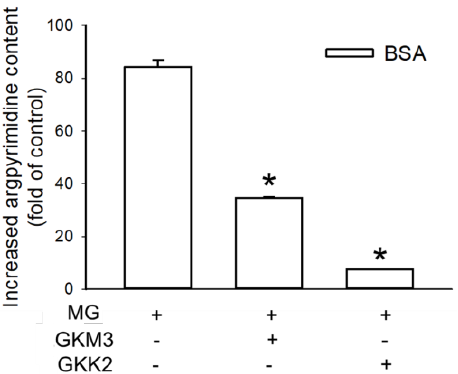
Figure 6. Effect of GKM3 and GKK2 on the formation of advanced glycation end products (AGEs) in the final stage of protein glycation. Data shown are means of ratio of values of glycated BSA groups versus values of native BSA groups obtained from three independent experiments. * means statistical differences vs. data of the group of BSA treated with MG only.